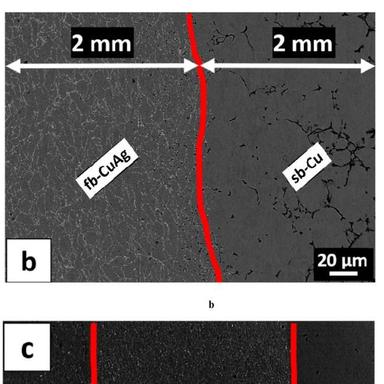
Interfaces of the (b) sub and middle layer, (a) middle and upper layer and (c) sub, middle and upper layer in same structure of FGM1.